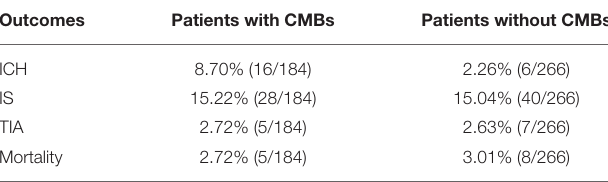
TABLE 2 | Outcomes in patients with and without CMB events.